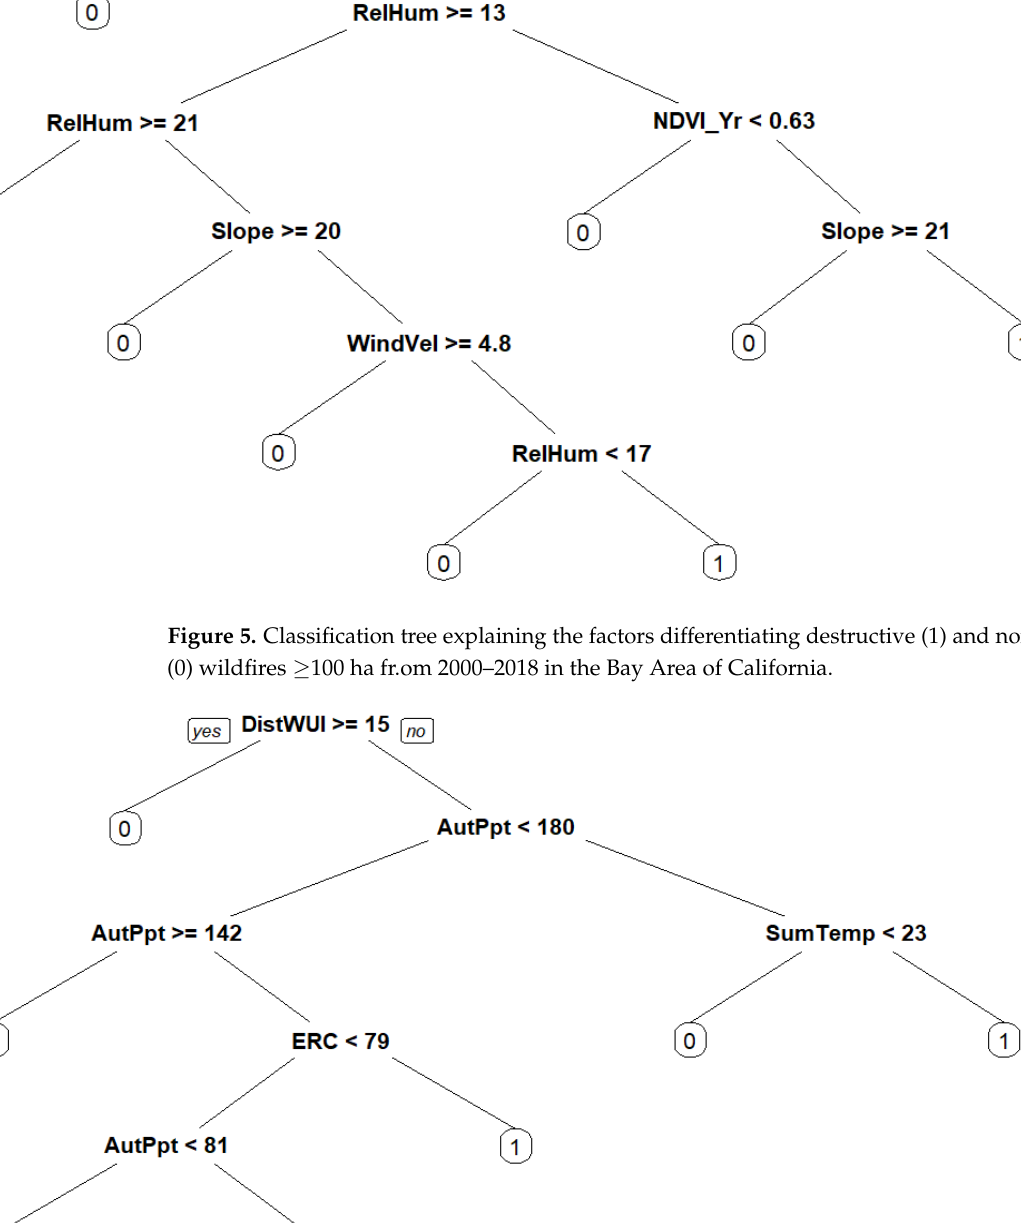
Figure 7. Classification tree explaining the factors differentiating destructive (1) and non-destructive (0) wildfires ≥ 100 ha from 2000 – 2018 in Southern California. 4. Discussion Not surprisingly, fires that resulted in structure loss were significantly larger and burned at higher severity than fires that did not result in structure loss. In general, most fires become large during severe fire-weather conditions, with strong winds or low fuel